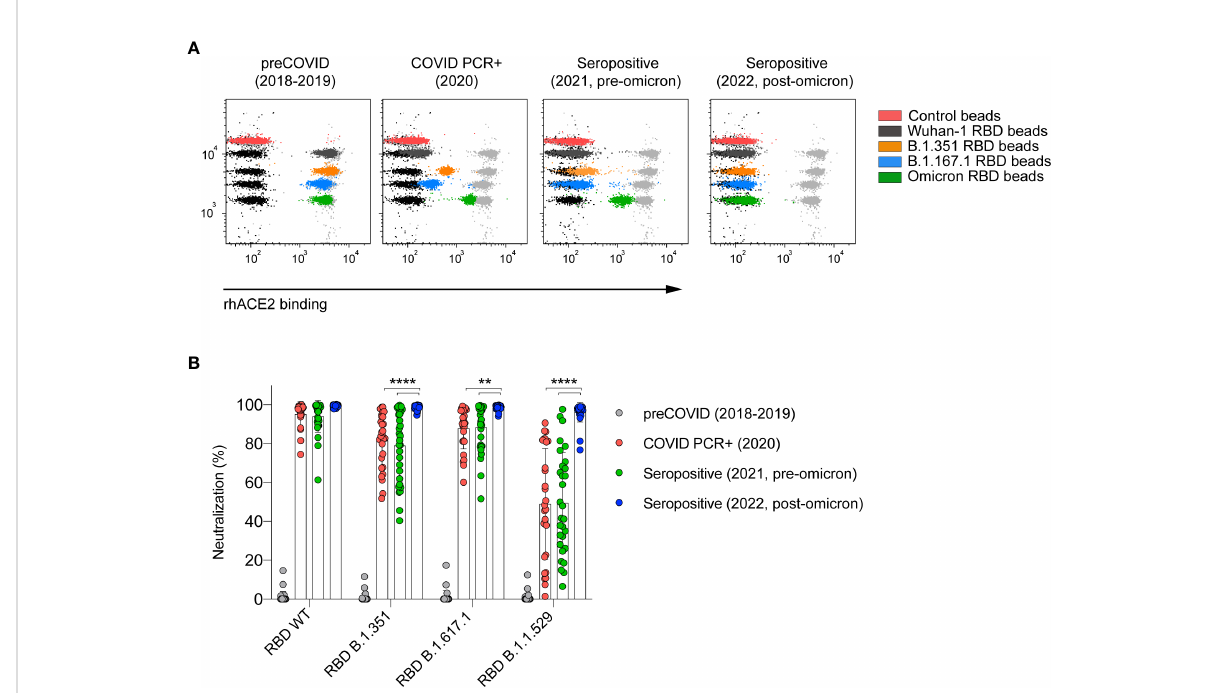
FIGURE 3 Serum neutralizing activity against SARS-CoV-2 variants depends on the time of sample collection. (A) Representative fl ow cytometry dot plots showing the neutralizing capacity of four serum samples corresponding to the indicated cohorts. (B) Comparison of the neutralizing capacity of serums corresponding to the indicated cohorts (n=30 per cohort). Statistical analyses were performed using an unpaired two-tailed Student ’ s t - test. Asterisks represent p values (** p <0.01 and **** p <0.0001).